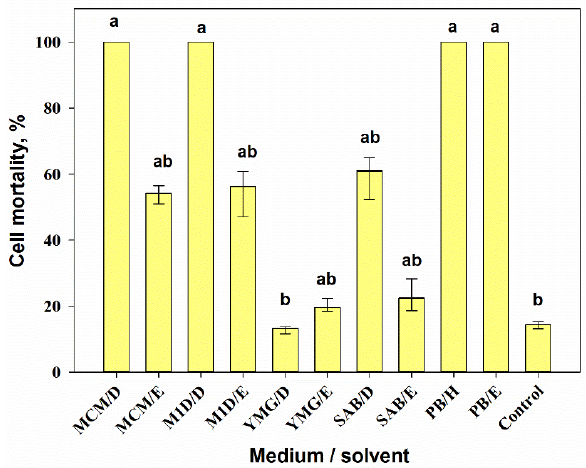
Figure 4. Cytotoxic activity of 0.01% extracts from Alternaria tenuissima MFP253011 cultures grown on various liquid and solid media 24 h post-treatment assayed on Sf9 cells. Median values with 25–75% quartiles marked with the same letter did not differ significantly at the level of p = 0.05 according to Dunn’s test. D—dichloromethane, E—ethyl acetate,